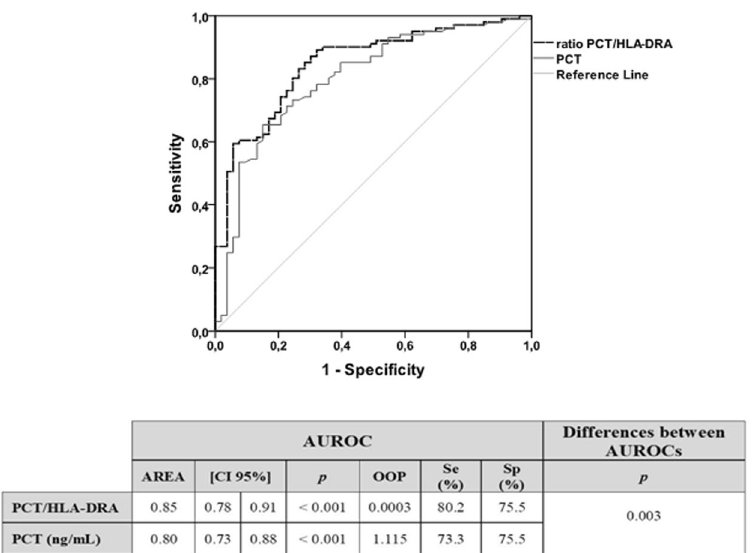
Figure 2. AUROC analysis for the differential diagnosis between sepsis patients and surgical controls with no infection in the derivation cohort. OOP: Optimal operating point; Se: sensitivity; Sp: